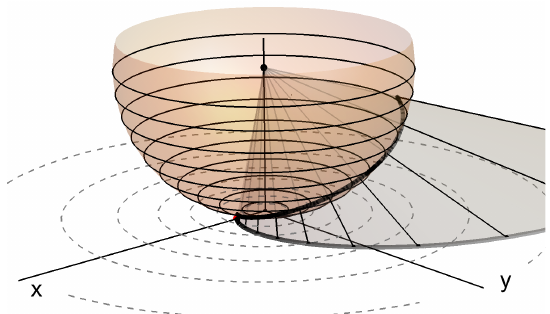
Figure 4. 3D construction of the stereographic projection Σ from S 2 onto its tangent polar plane E 2 including the image on S 2 of the geodesic orbit on V 1 shown in Figure 3a. The eye position is at the projection center of S 2 . Gray lines (virtually corresponding to light rays) show the projection through the curve image on S 2 to the curve on the polar x − y plane E 2 shown in Figure 3b. Notice that neither of the V 1-geodesic-curve images on S 2 and E 2 are geodetic in those latter two manifolds: starkly far from geodetic indeed.